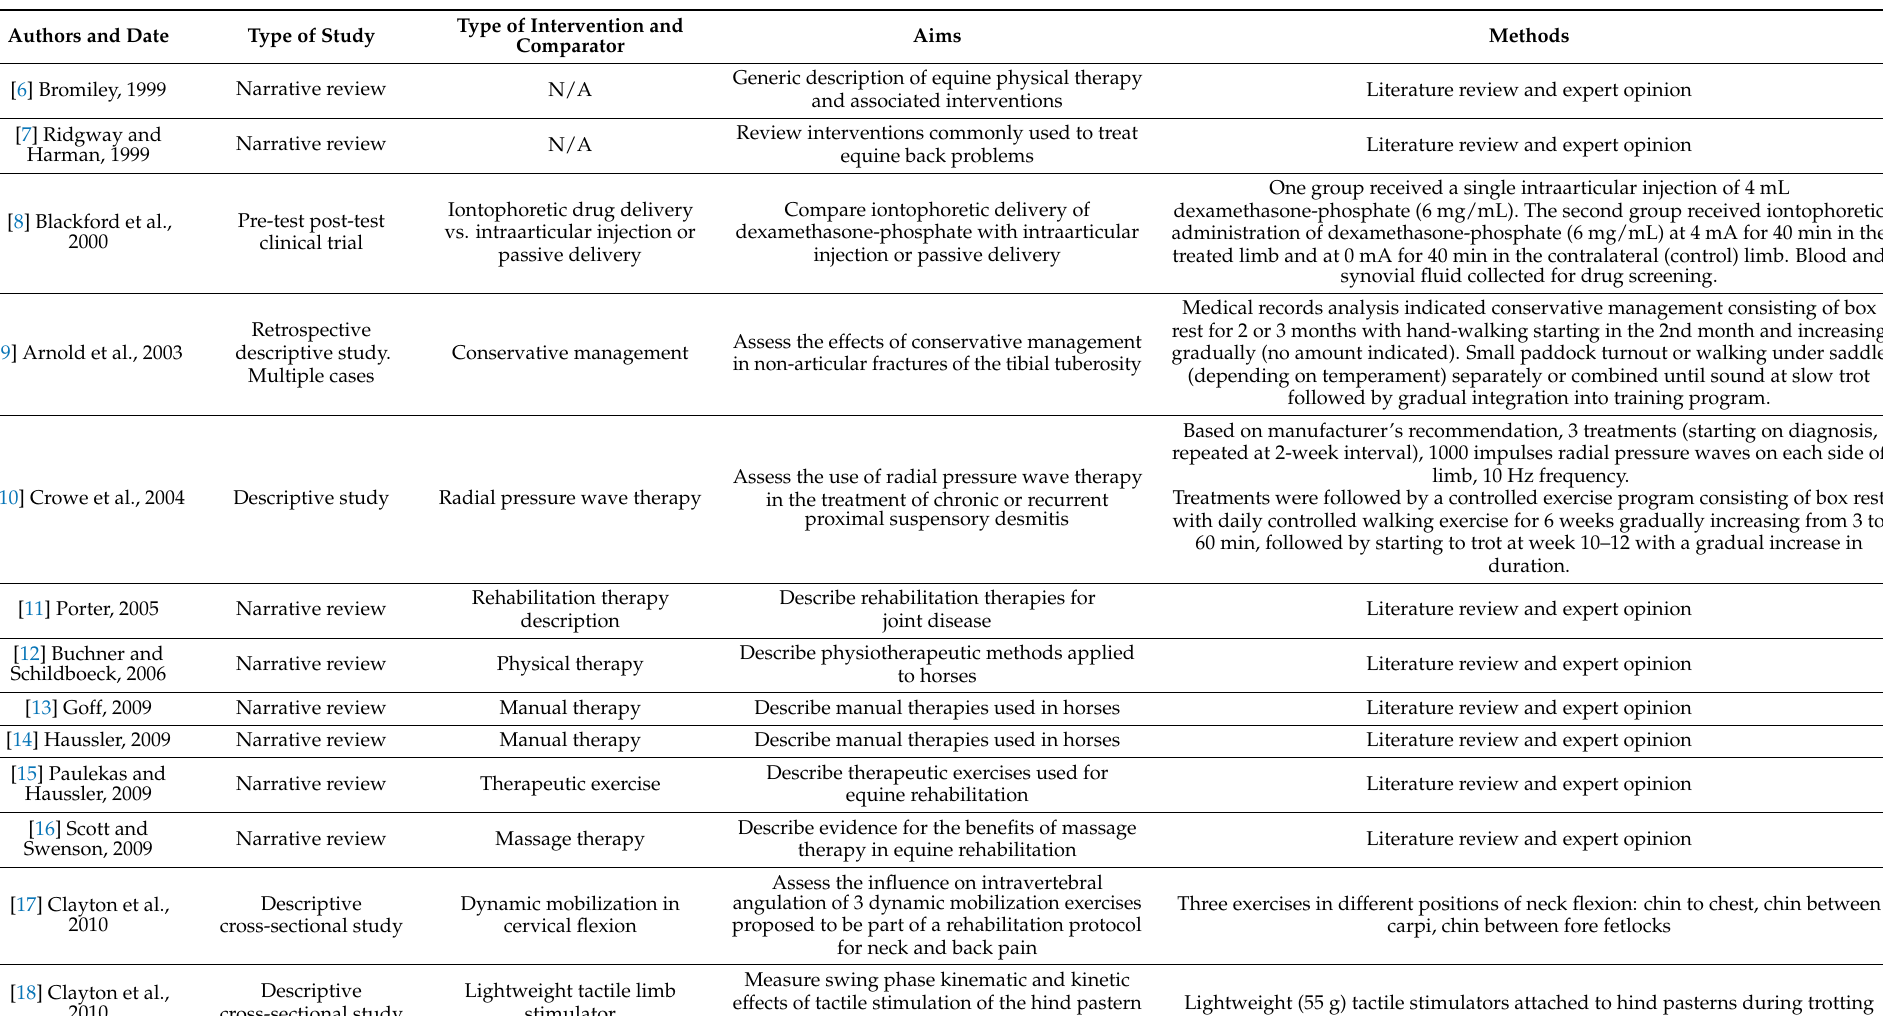
Table 1. Papers included in the review listed in chronological